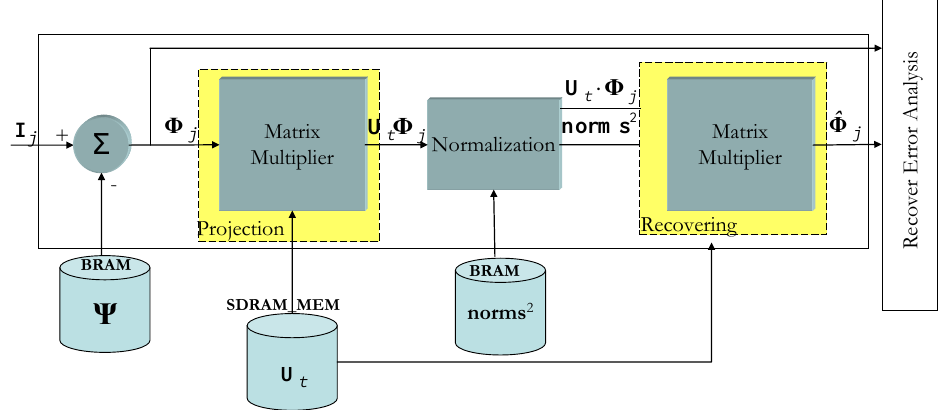
Figure 4. Block diagram of the modules of the design in VHDL of the on-line stage of the